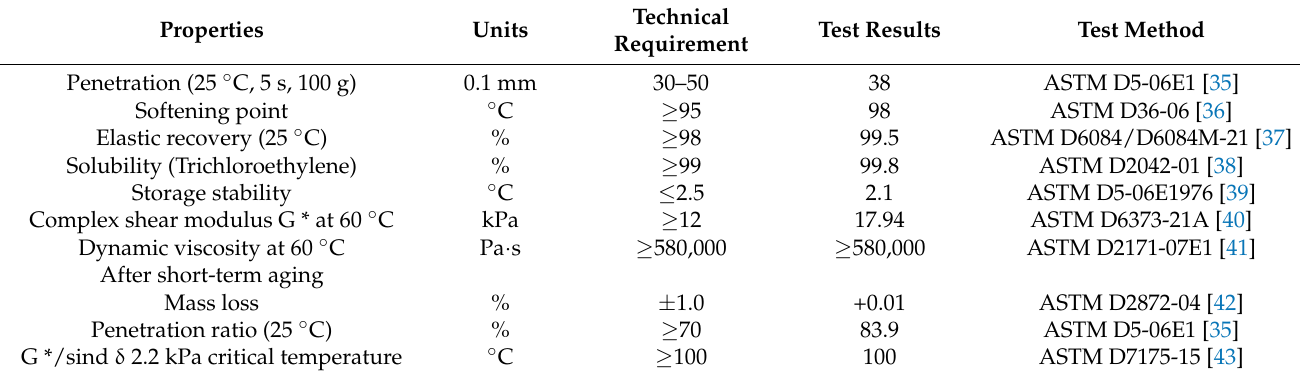
Table 1. Technical index of the high-viscosity and high-elasticity modified